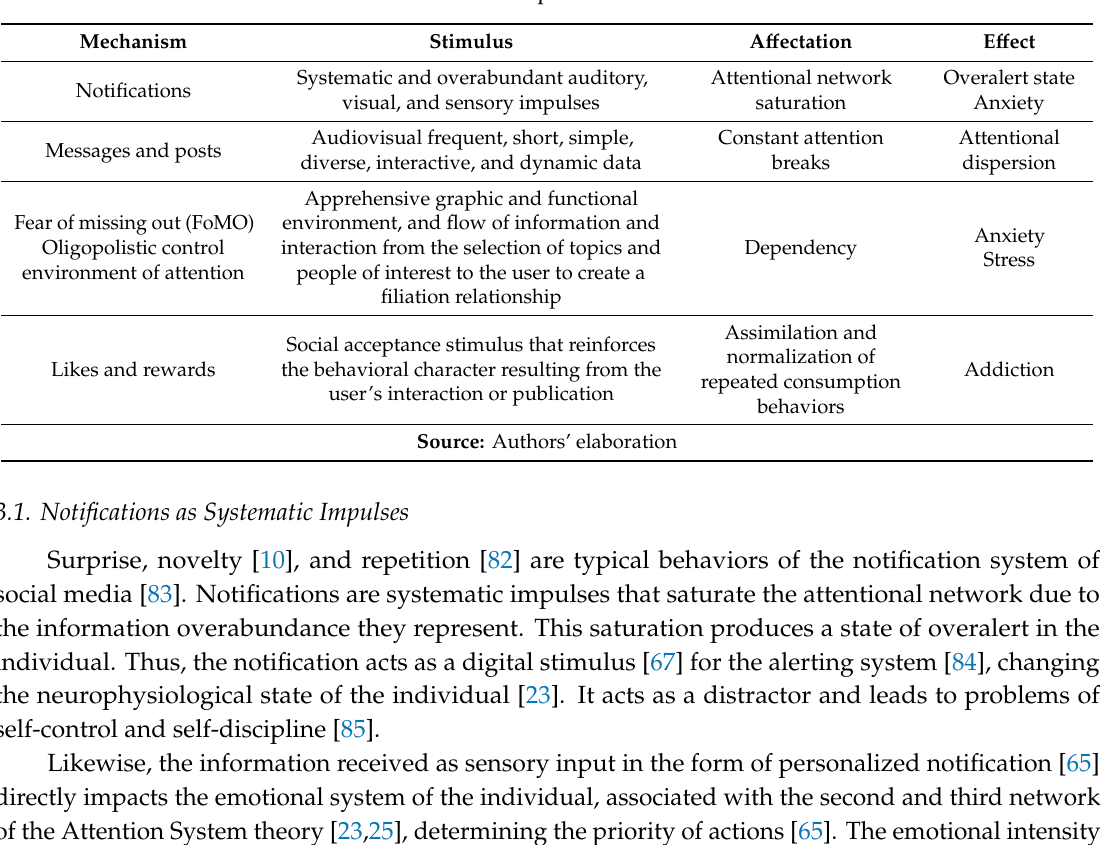
Table 1. Mechanisms of social media operation and e ff ects on human